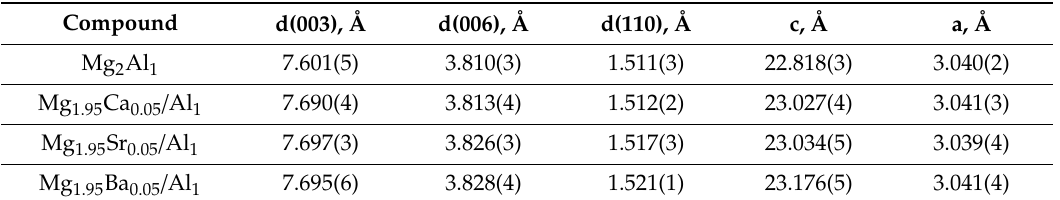
Table 1. The interplanar spacings and lattice parameters of sol–gel derived Mg 1.95 M 0.05 / Al 1 (M = Ca, Sr and Ba)